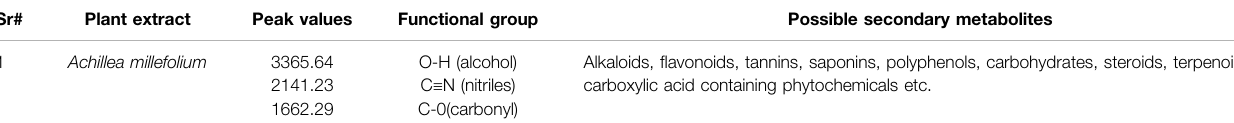
TABLE 3 | Spectral interpretation of FTIR spectra of plant extract.